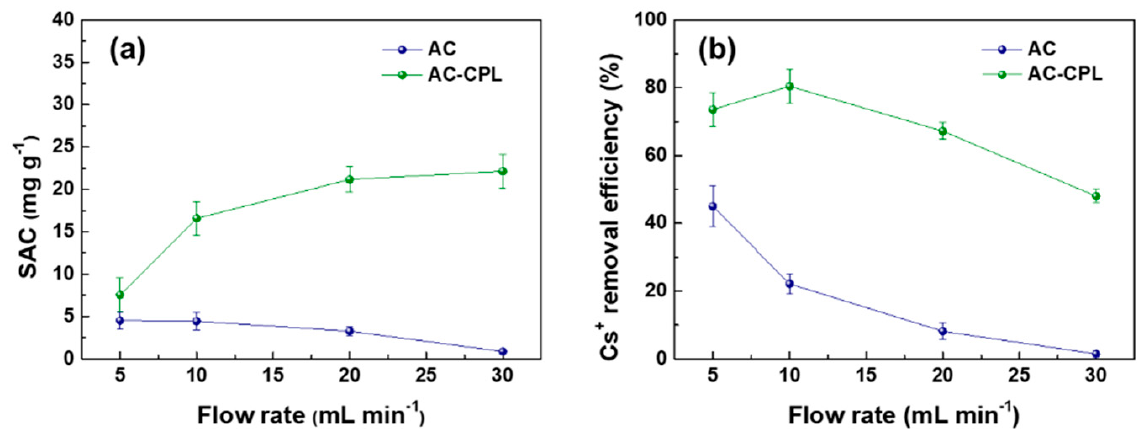
Figure 5. Comparison of the AC, and the AC-CPL for ( a ) specific adsorption capacity of Cs + ions and ( b ) removal efficiency according to the flow rate (Experimental conditions: Influent of 200 mg L − 1 Cs + ions at pH 3 solution was fed at 1.2 V for 10 min).